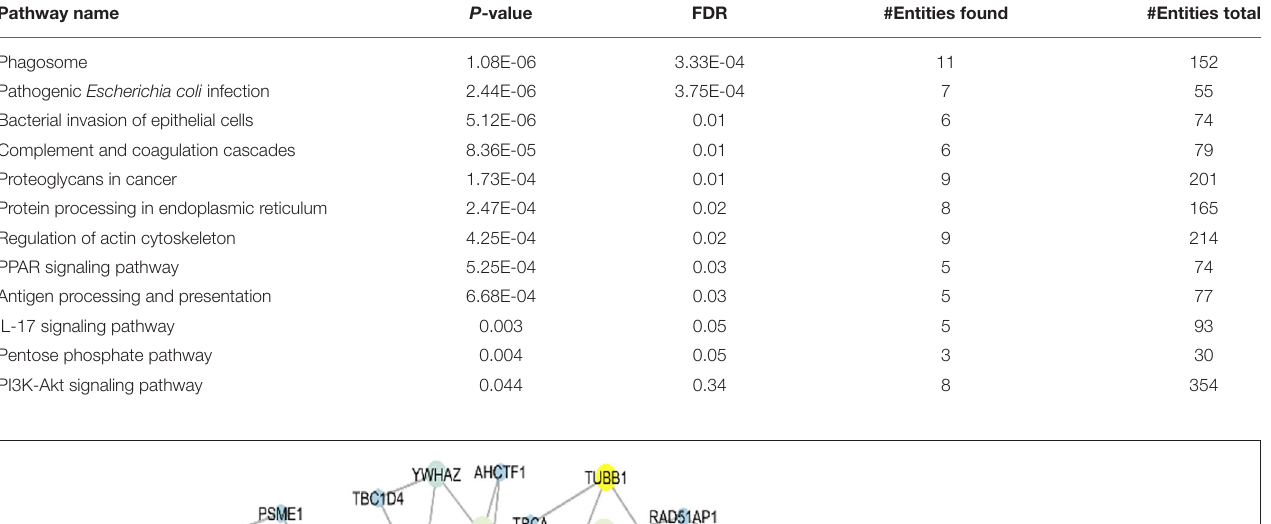
TABLE 3 | Pathway analysis of the proteome of co-cultured PBMC vs. PBMC alone.